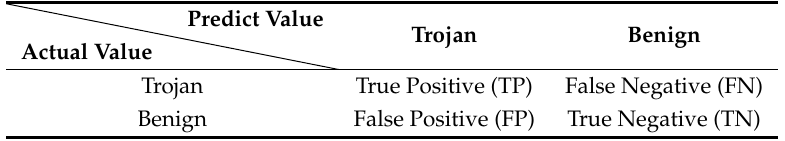
Table 4. Confusion